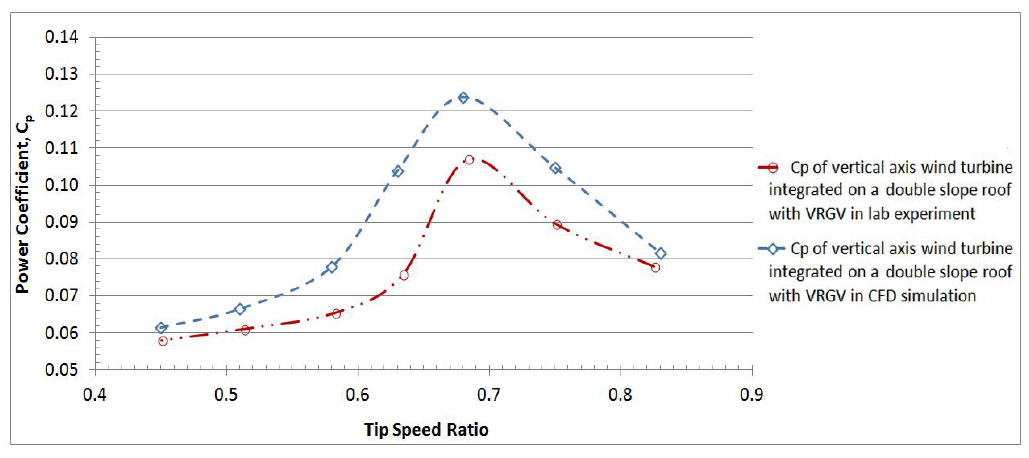
Figure 25. Comparison of power coefficient between the experimental and CFD numerical data.